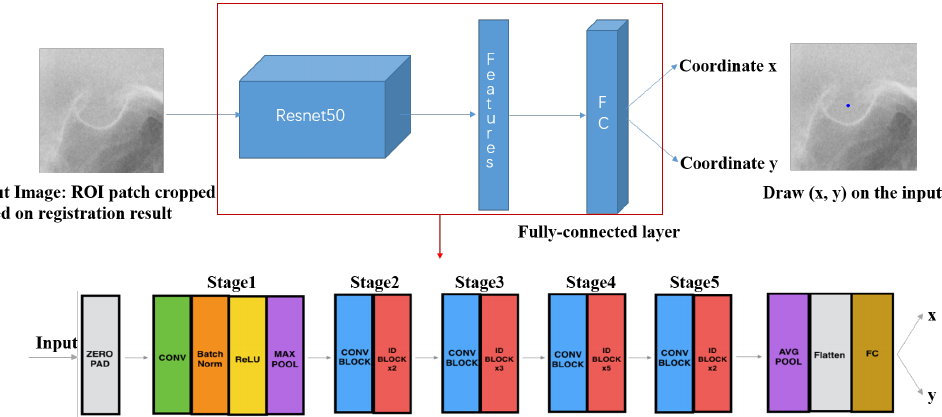
Figure 7. The architecture of ResNet50, the identity block and convolutional block add the former input to the later output. For identity block, it directly adds the former input to the later output. While for convolutional block, before adding, the former input first goes through a convolutional layer to make it the same size with later